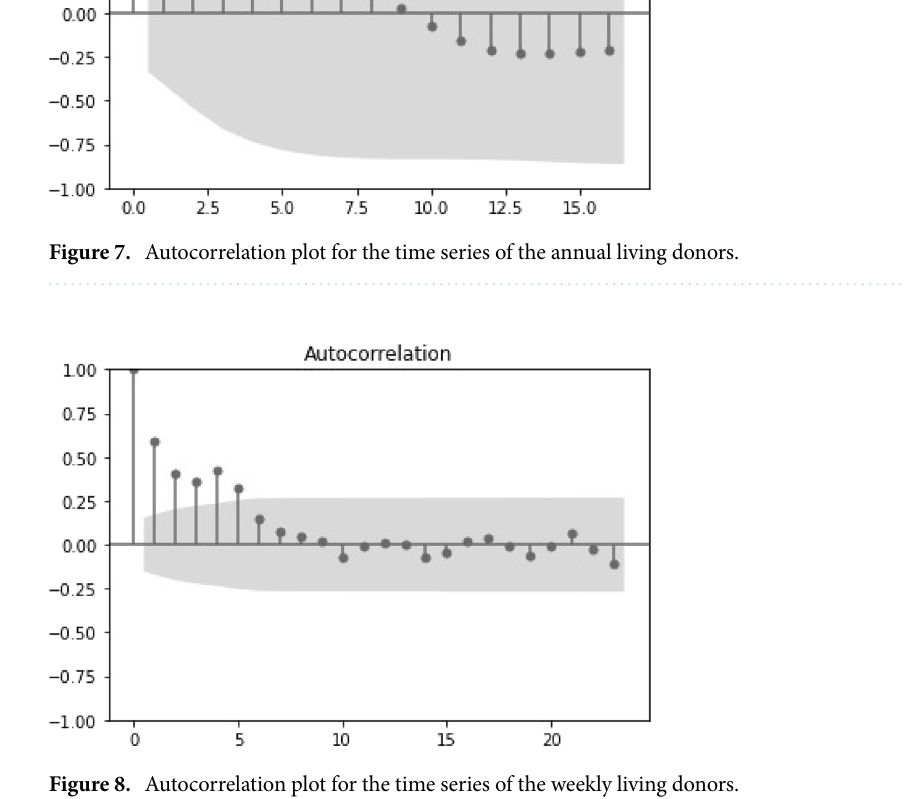
Figure 8. Autocorrelation plot for the time series of the weekly living